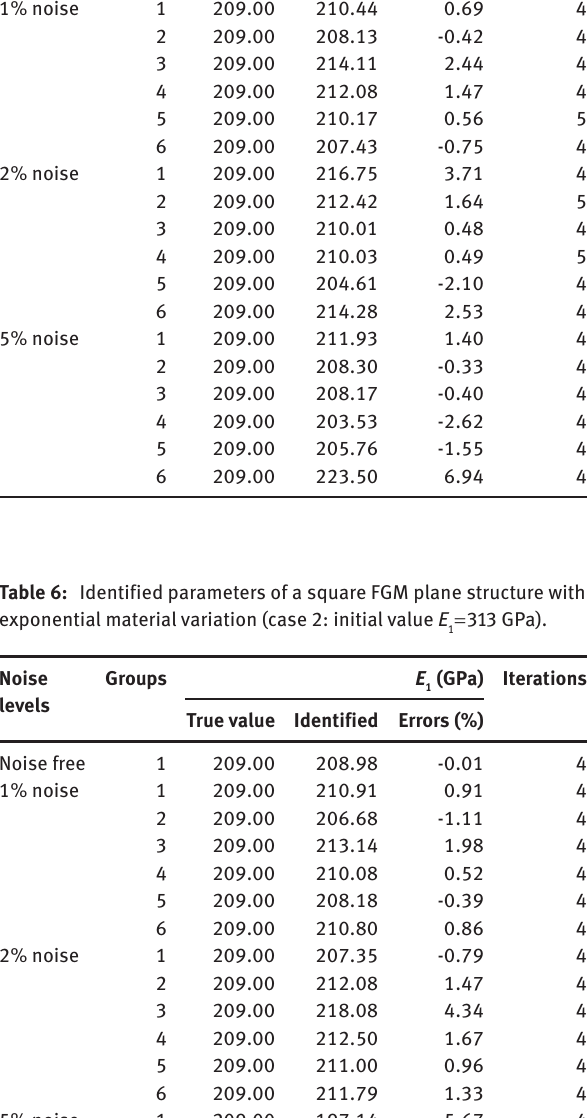
Table 5: Identified parameters of a square FGM plane structure with exponential material variation (case 1: initial value E